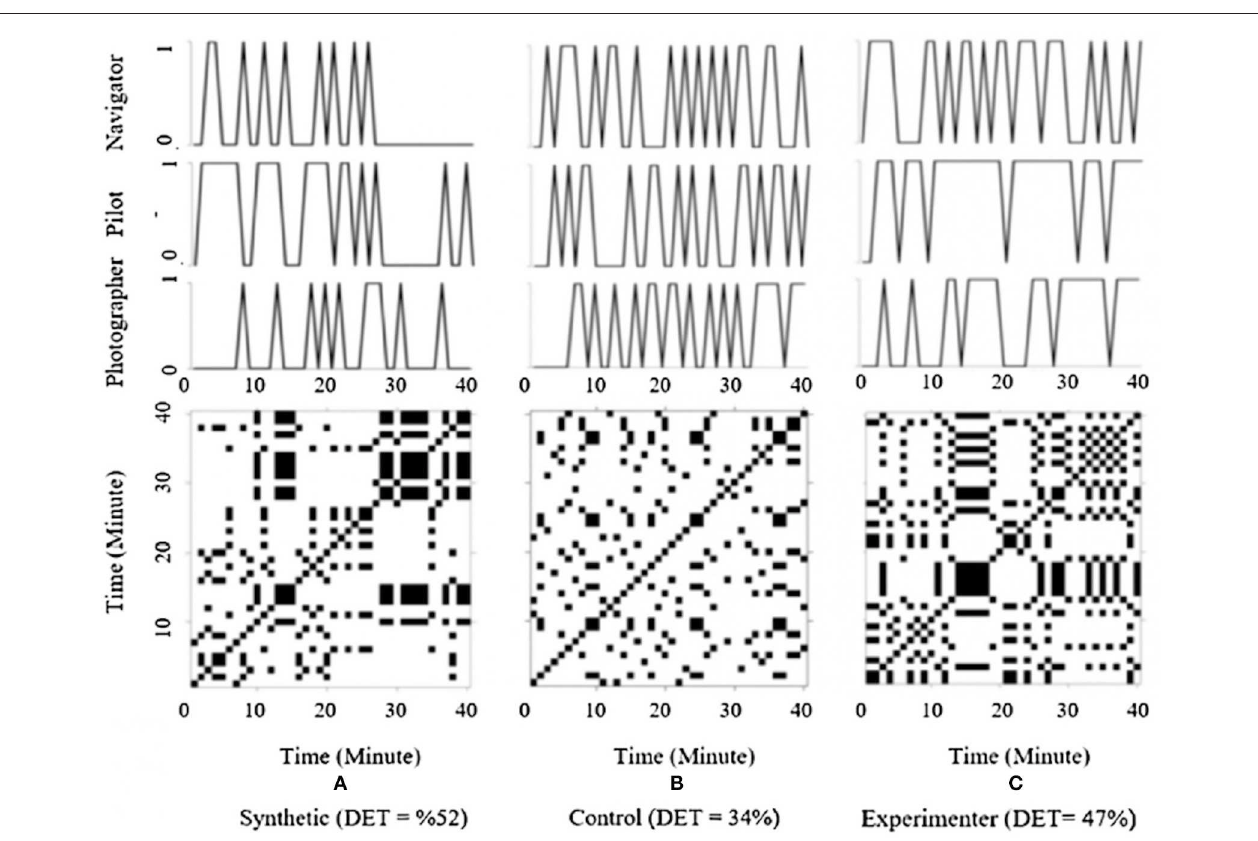
FIGURE 3 | Example joint recurrence plots for three RPAS teams’ interactions in three conditions—length 40 min: (A) synthetic, (B) control, and (C) experimenter teams (from Demir et al., 2018b; reprinted with